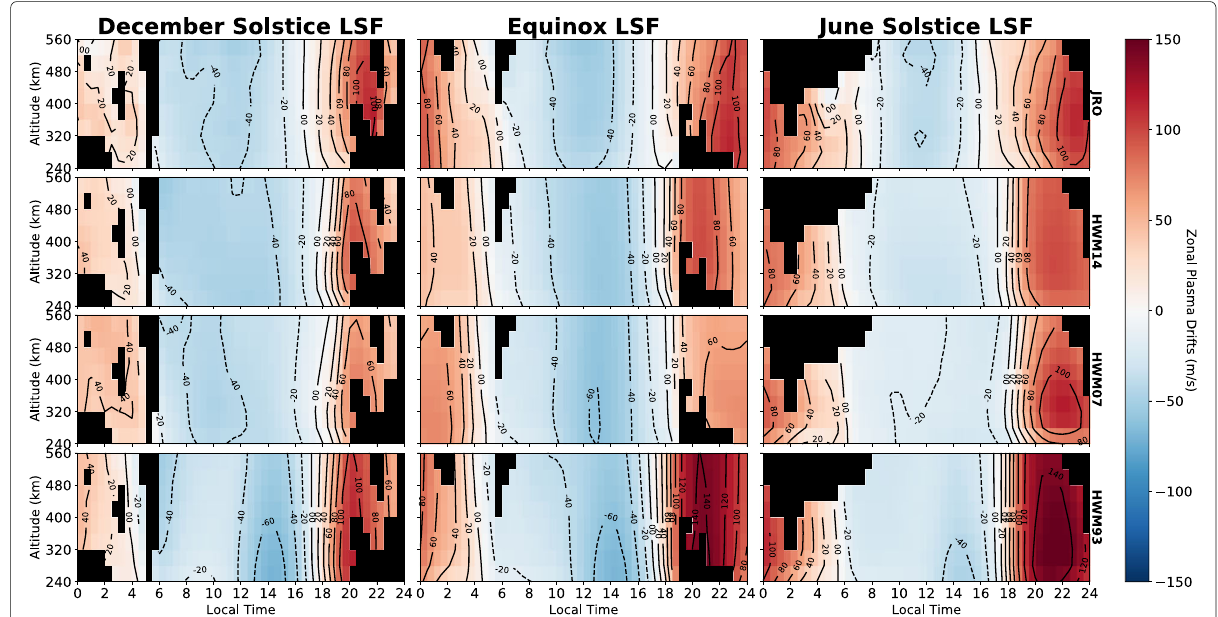
Fig. 2 Local time versus height color plots for the Jicamarca climatological zonal drifts and the model zonal drifts using HWM14, HWM07, and HWM93, during LSF conditions